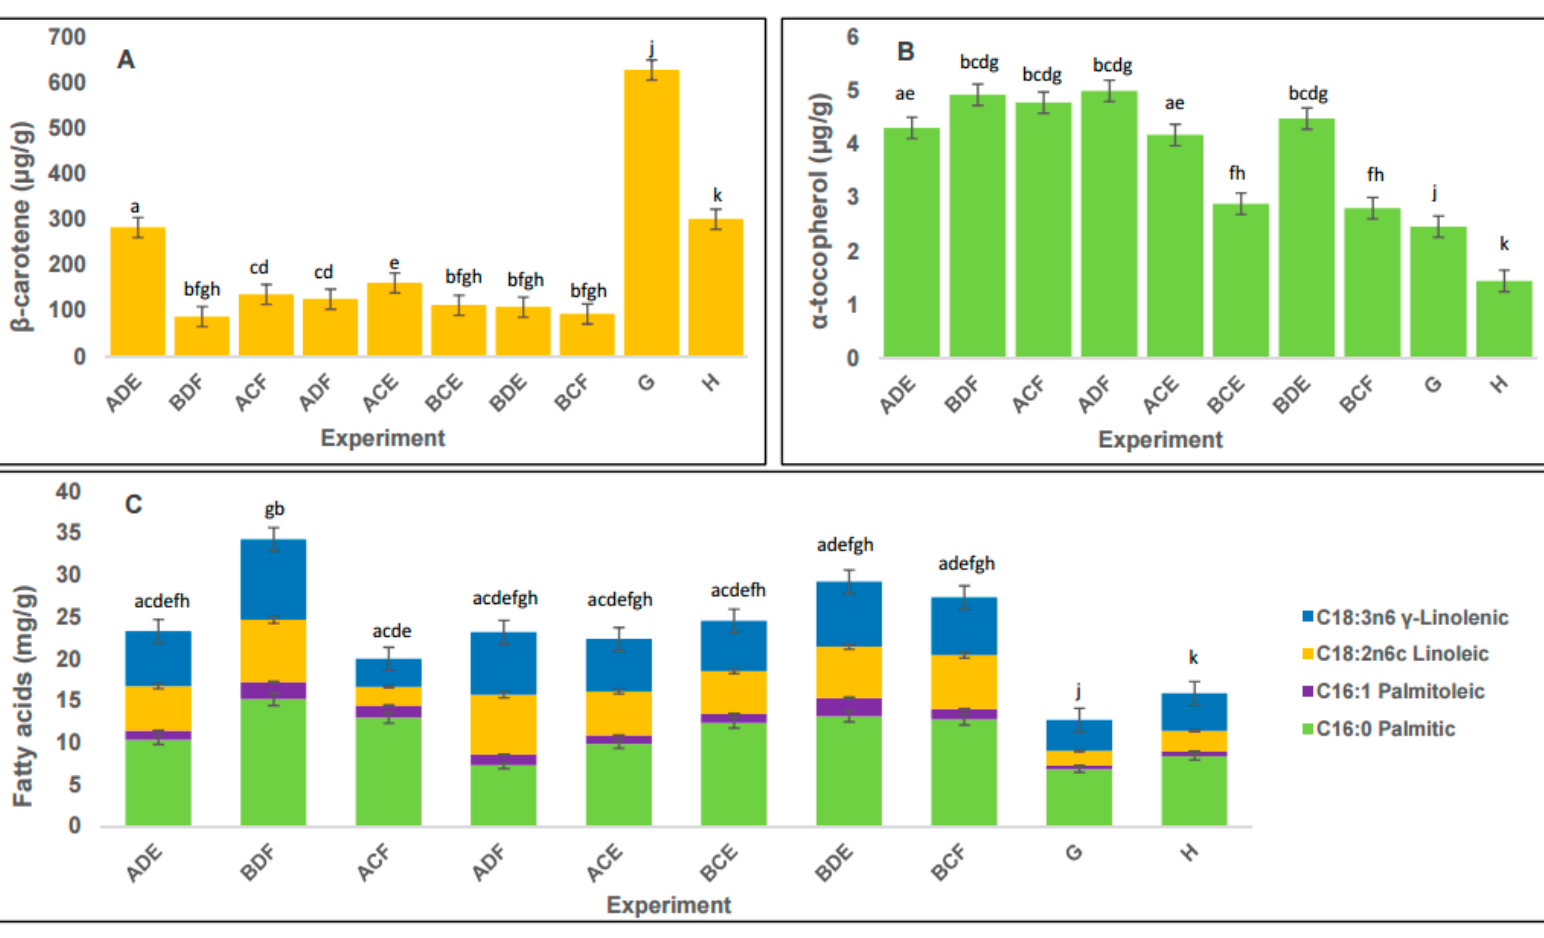
Figure 1. Functional lipophilic compound concentration of SFE and MAE extracts of Arthrospira platensis . ( A ) β -Carotene ( µ g/g); ( B ) α -tocopherol ( µ g/g); ( C ) fatty acids (mg/g). Values are presented as a mean ± standard deviation ( n = 2 for SFE and n = 3 for MAE). Different letters in the bars are significantly different (LSD test, p < 0.05).